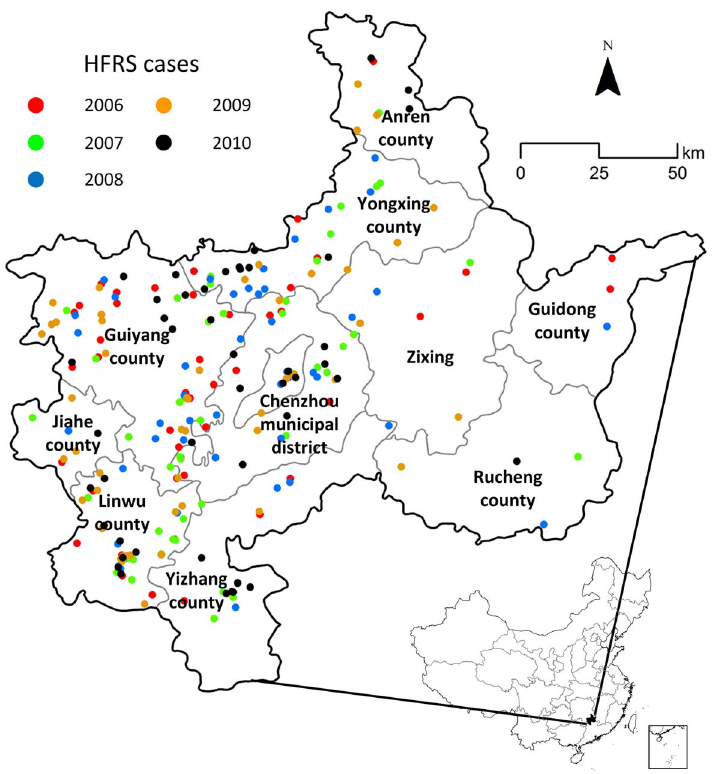
Figure 1. Distribution of hemorrhagic fever with renal syndrome (HFRS) cases in Chenzhou, 2006–2010.